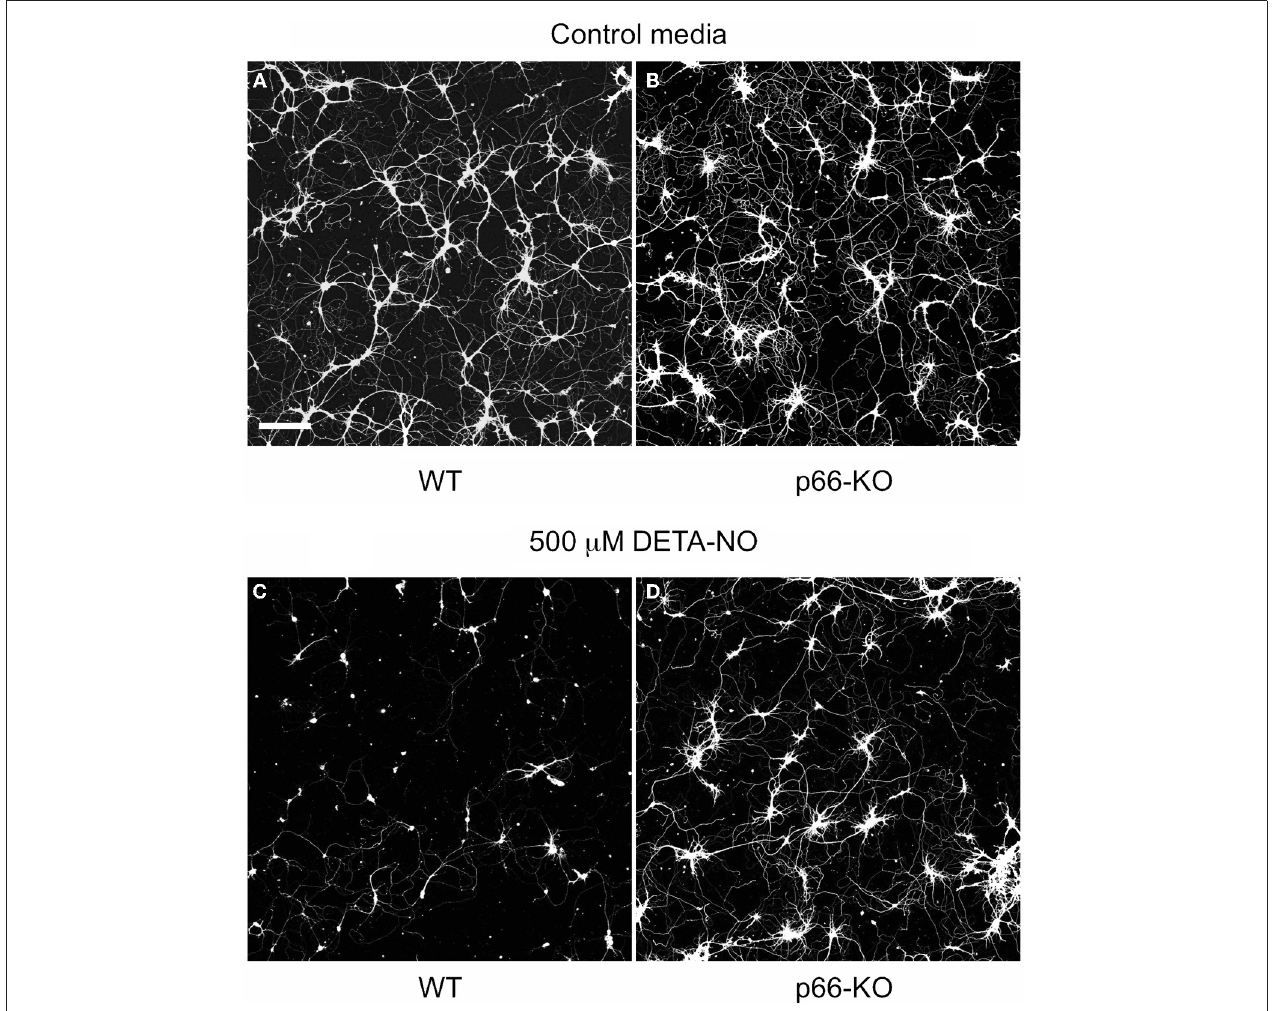
FIGURE 4 | p66-KO neurons show greater preservation of neuronal structure compared to WT neurons following DETA-NO treatment. Representative images of week-old p66-KO and WT neurons at 24h post-treatment with either control media (A,B) or 500 μ M DETA-NO (C,D) ;